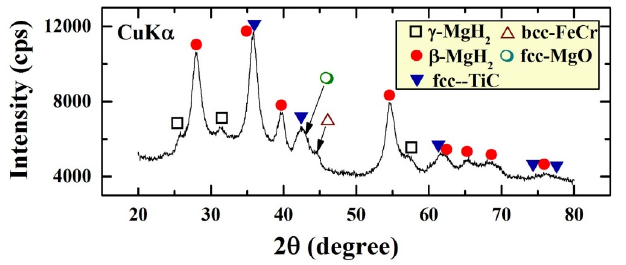
Figure 1. XRD patterns of MgH 2 nanocrystalline powders obtained after 200 h of RBM time and then ball-milled with TiC powders for 50 h. ball-milled with TiC powders for 50